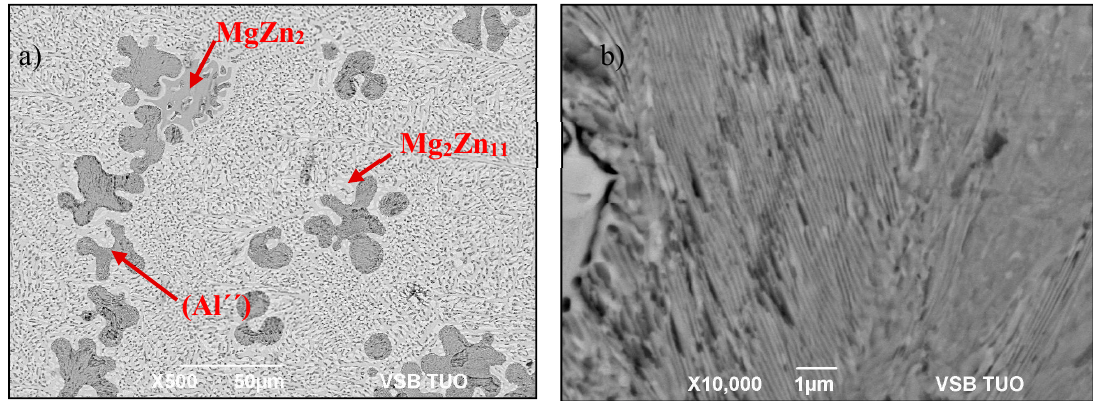
Figure 8. The Zn5Al3Mg solder ( a ) microstructure, ( b ) detailed view of darker phase (Al“).